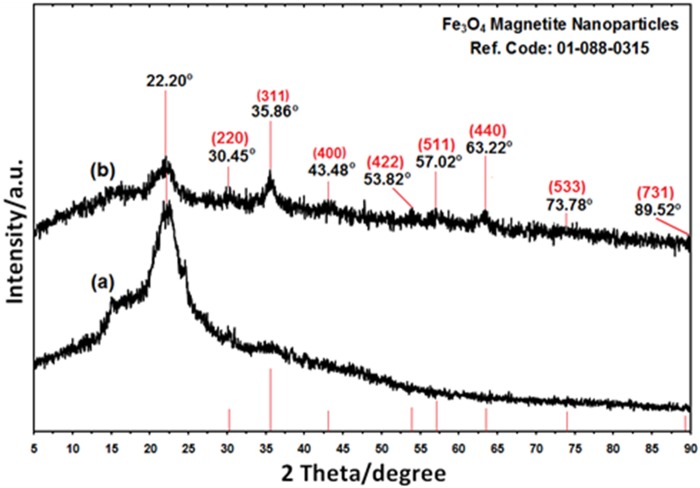
The PXRD of rice straw and rice straw/Fe3O4-NCs with the related peaks respectively (a,b).